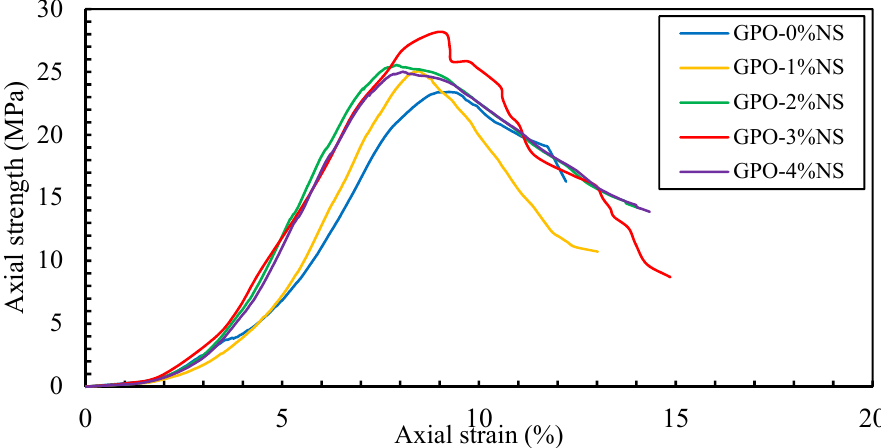
Figure 5. Compressive stress–strain efficacy of carbon-fiber-reinforced GPO composite paste with various contents of